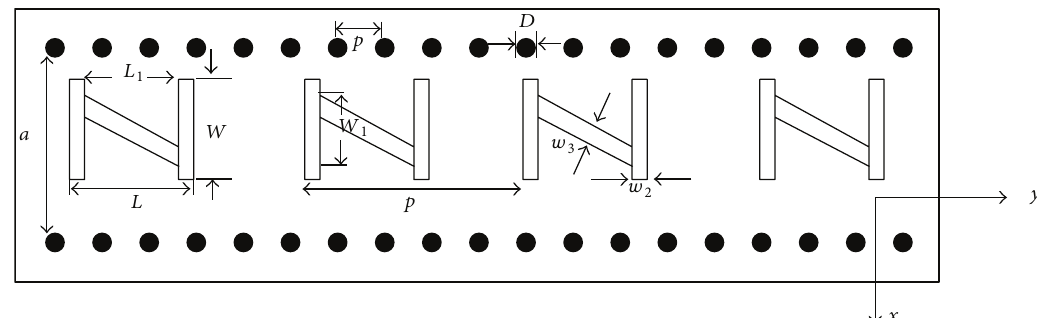
Figure 1: Geometry of the N-shaped slotted SIW: 𝑎 = 15.5 mm, 𝜀 𝑟 = 2.2 , 𝑝 = 1.2 mm, 𝐷 = 0.8 mm, 𝑤 2 = 0.5 mm, and 𝑤 3 = 0.6 mm.